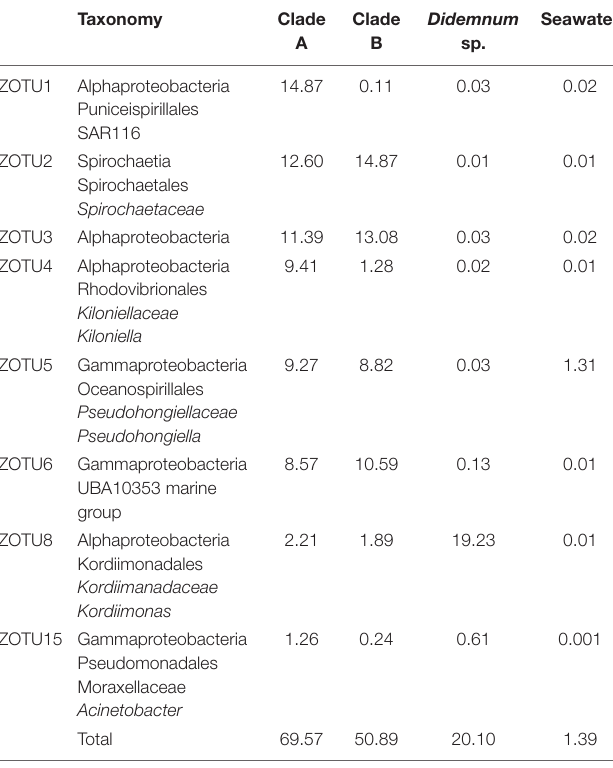
TABLE 3 | Taxonomy assigned and read frequency of the eight clade A core ZOTUs in clade A, clade B, Didemnum sp., and seawater